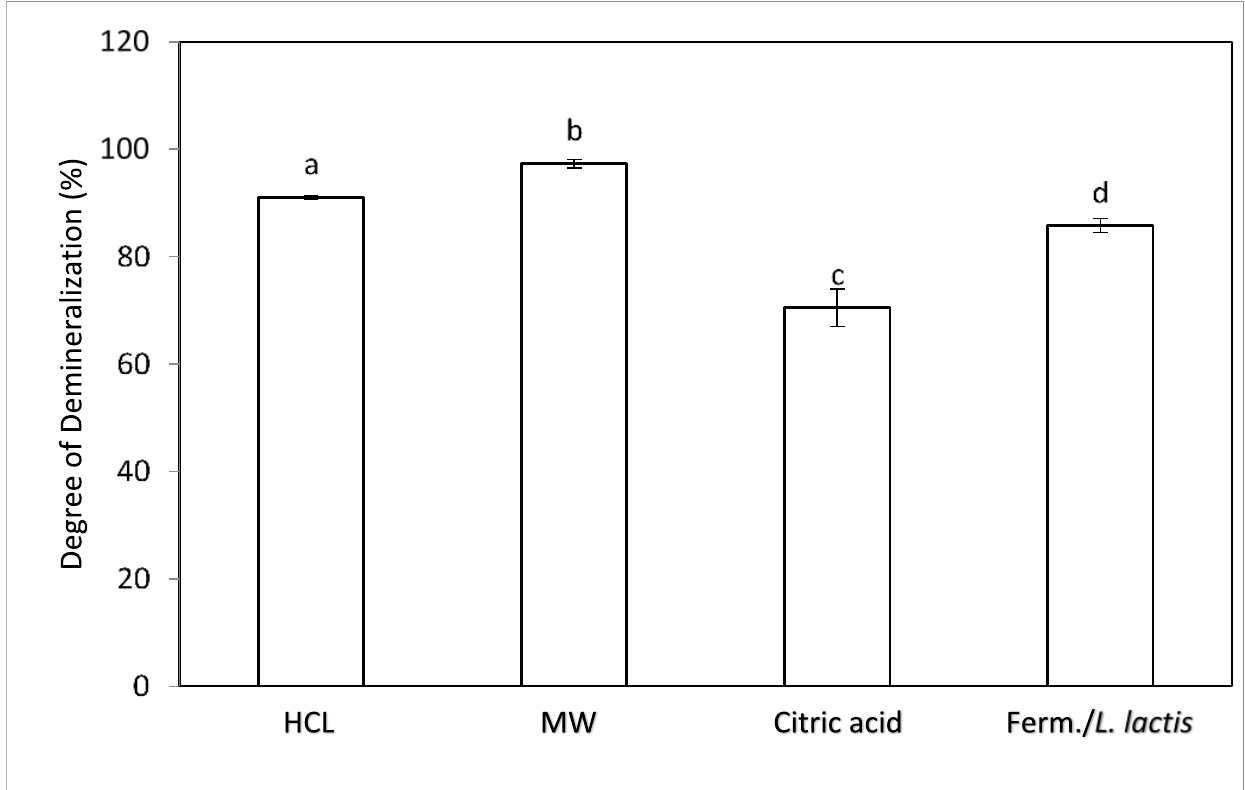
Figure 2. Efficiency of demineralization methods based on the degree of demineralization. Error bars indicate the standard error based on the variation in the %DDM. Different subscript letters indicate significant differences ( p < 0.05) among the means of the %DDM obtained from each sample treated with a different demineralization process.